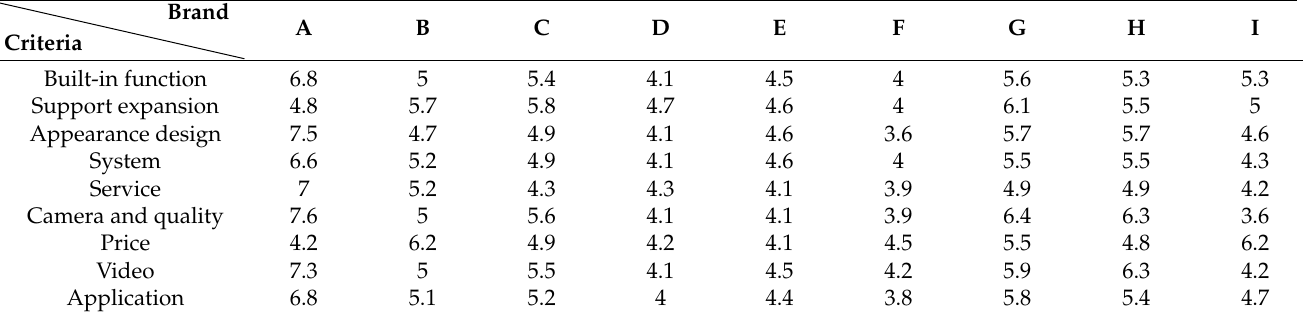
Table 5. Original matrix of the word of mouth.